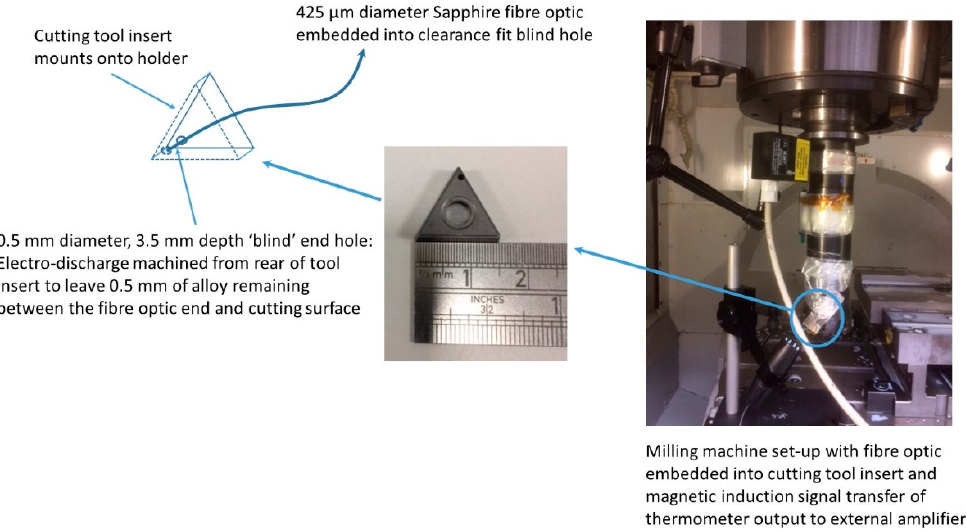
Figure 12. Milling machine set-up and schematic illustration of cutting tool insert configuration.